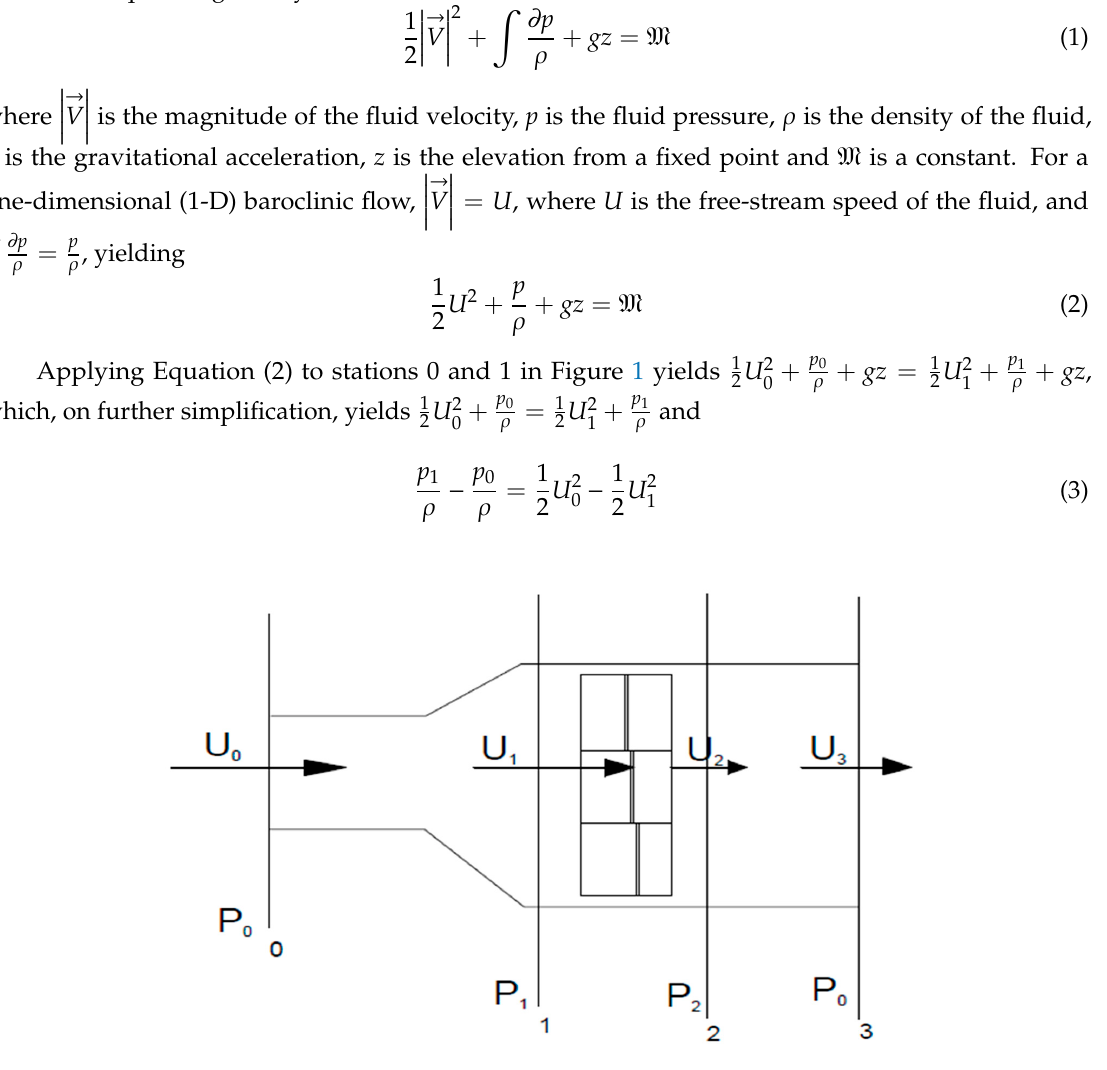
Figure 1. Control volume of the AVAWT.